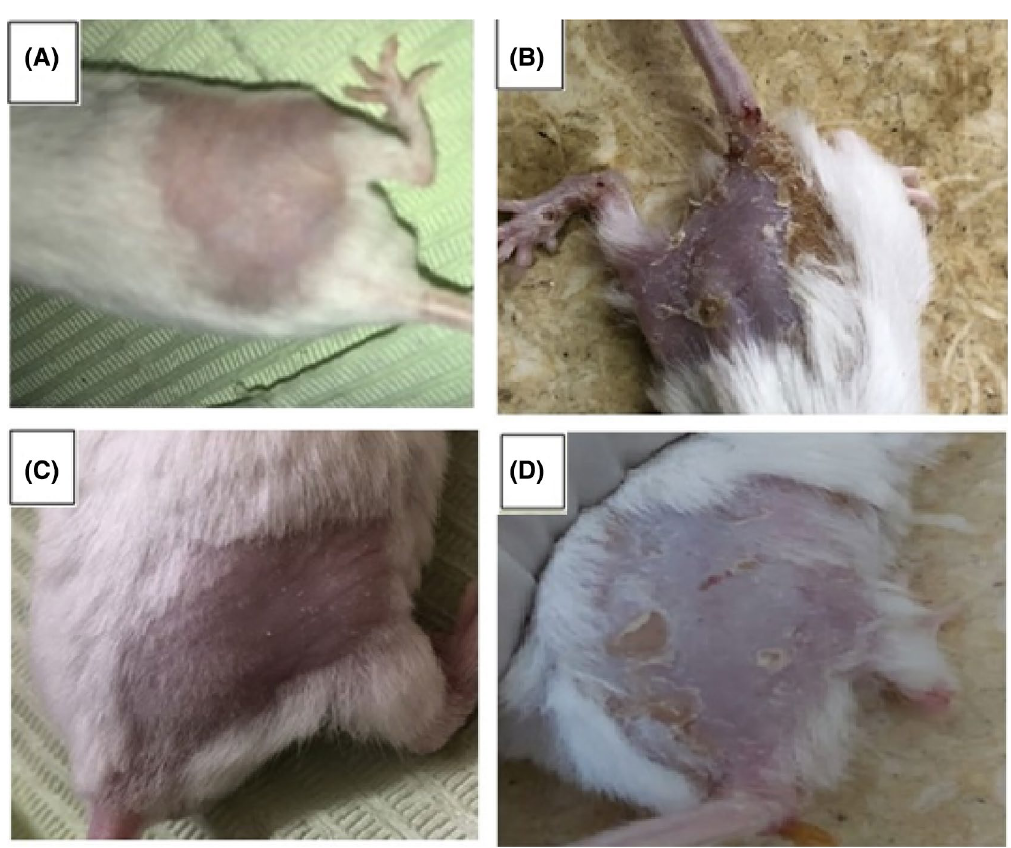
Figure 4. Morphological variations in skin appearance in: ( A ) Negative control group (Group I animals), ( B ) Positive control DMBA-induced skin carcinogenesis group (Group II animals), ( C ) nobiletin composite PEVs formulation (F13) treated group III animals, ( D ) nobiletin solution treated group IV